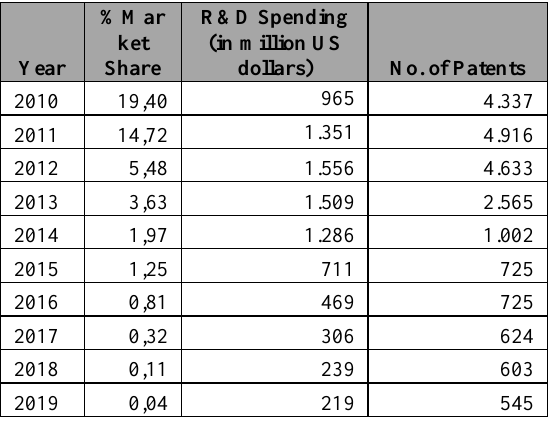
Table 7: Samsung Descriptive Statistics